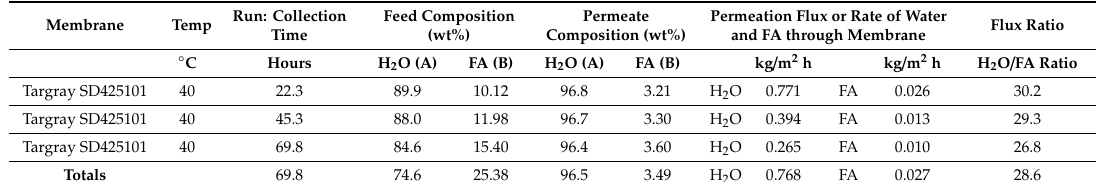
Table 6. Extended time batch permeation run using a Targray SD425101 membrane, starting with 200 g solution having a 10.12 wt% FA feed solution concentration, and operating the system for a total of 69.84 h at a temperature of 40 ◦ C.